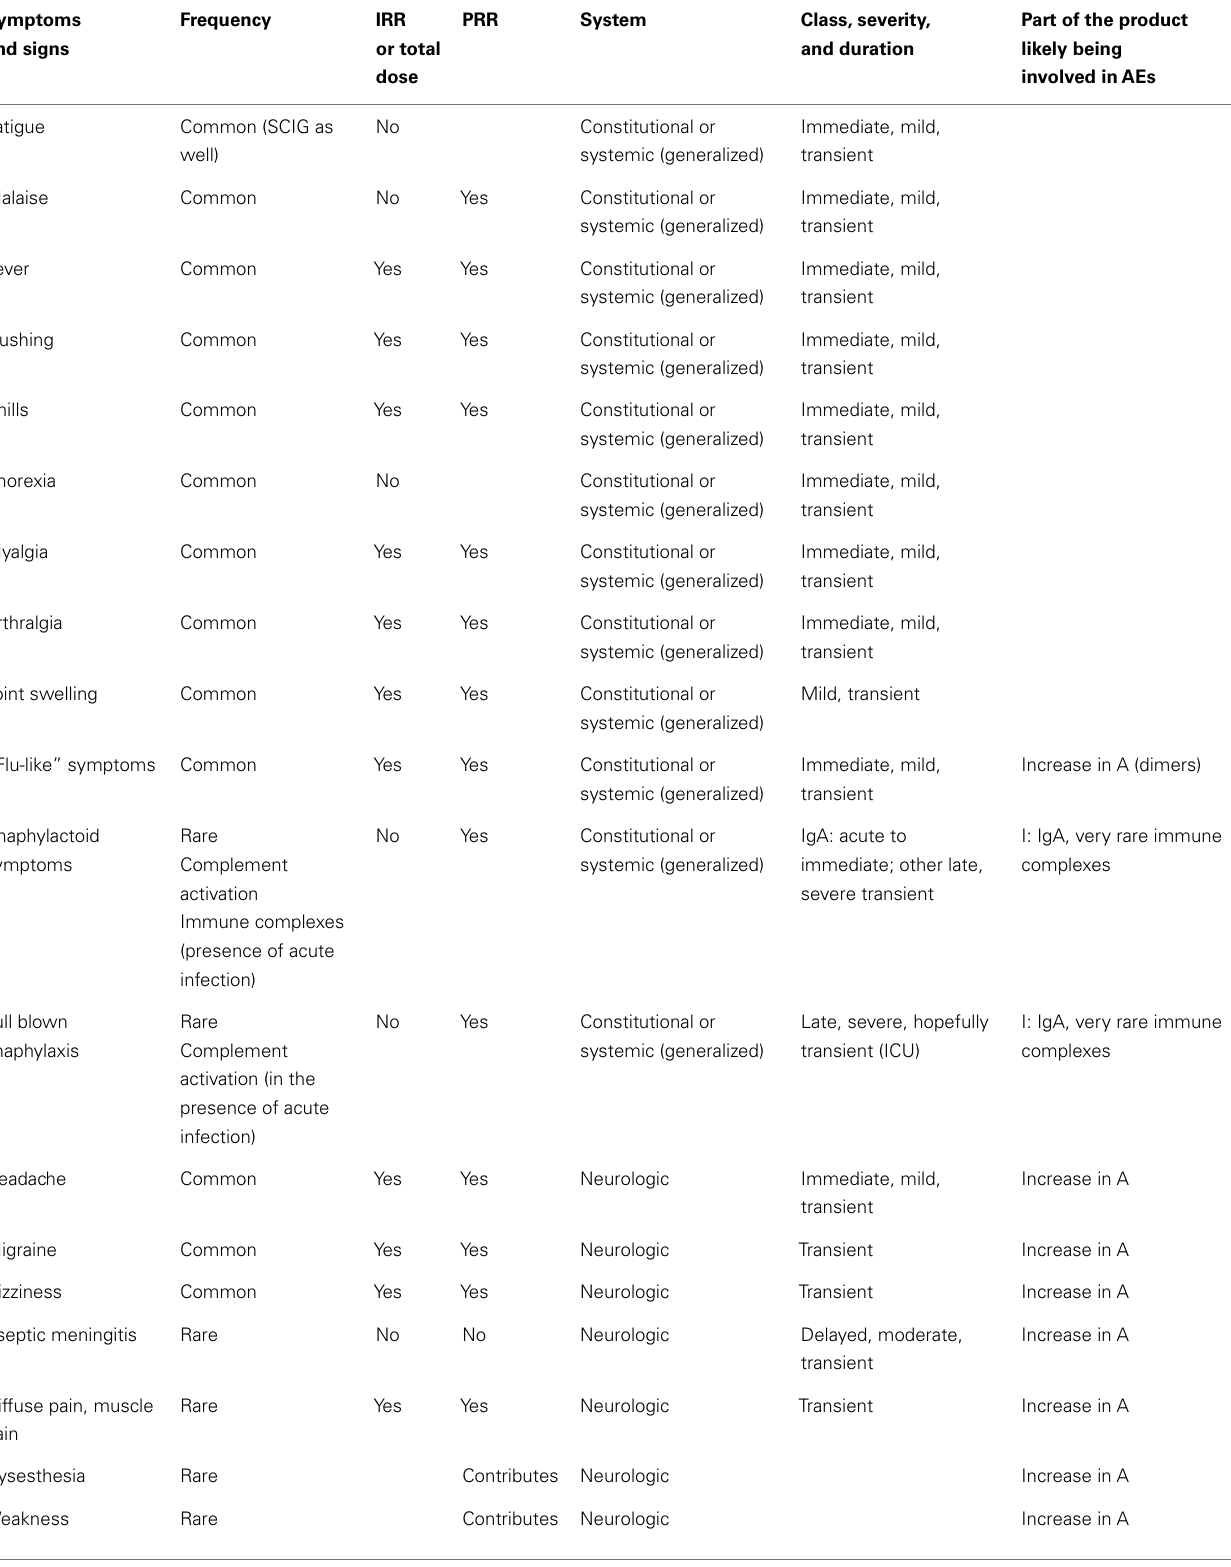
Table 1 |The tinge of the dark